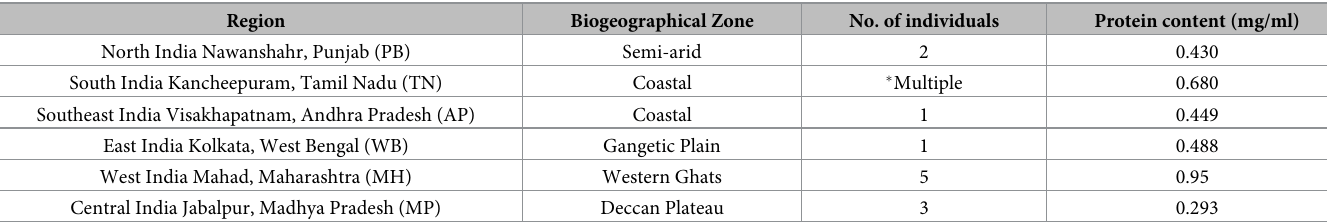
Table 1. Details of D . russelii venom